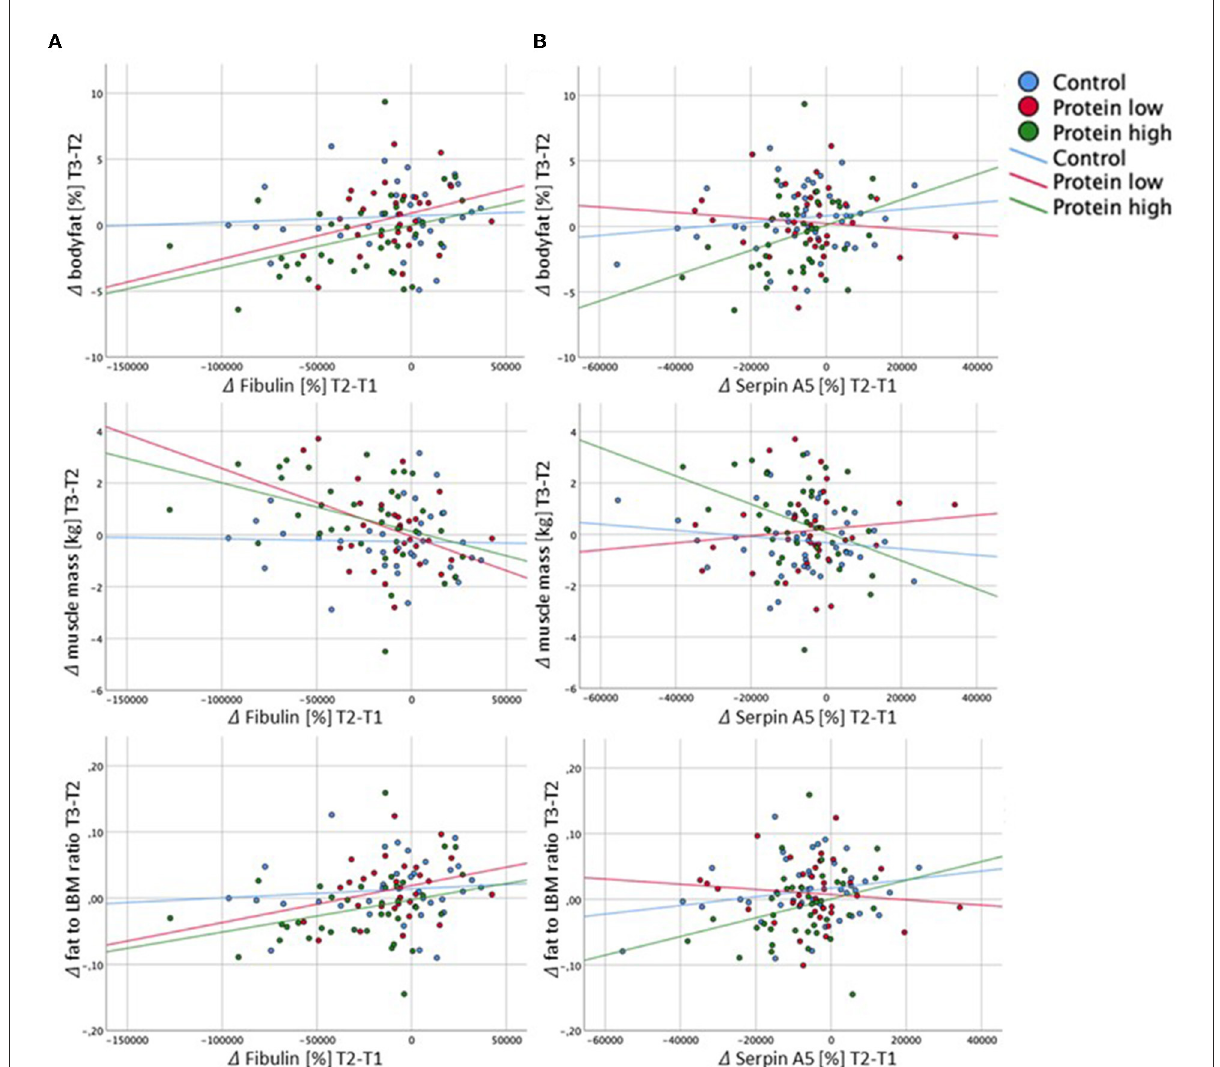
FIGURE7 Correlations of deltas ( 1 ) from fibulin (A) and serpin A5 (B) with body composition parameters. (A) Significant and borderline-significant correlations of delta fibulin (T2-T1): delta bodyfat (T3-T2): HP: r = 0.364, p = 0.029; delta muscle mass (T3-T2): RP: r = − 0.367, p = 0.050; HP: r = − 0.388, p = 0.019; delta fat to LBM ratio (T3-T2): HP: r = 3.05, p = 0.070. (B) Significant and borderline significant correlations of delta serpin A5 (T2-T1): delta bodyfat (T3-T2): HP: r = 0.348, p = 0.028; delta muscle mass (T3-T2): HP: r = − 0.361, p = 0.022; delta fat to LBM ratio (T3-T2): HP: r = 0.280, p =